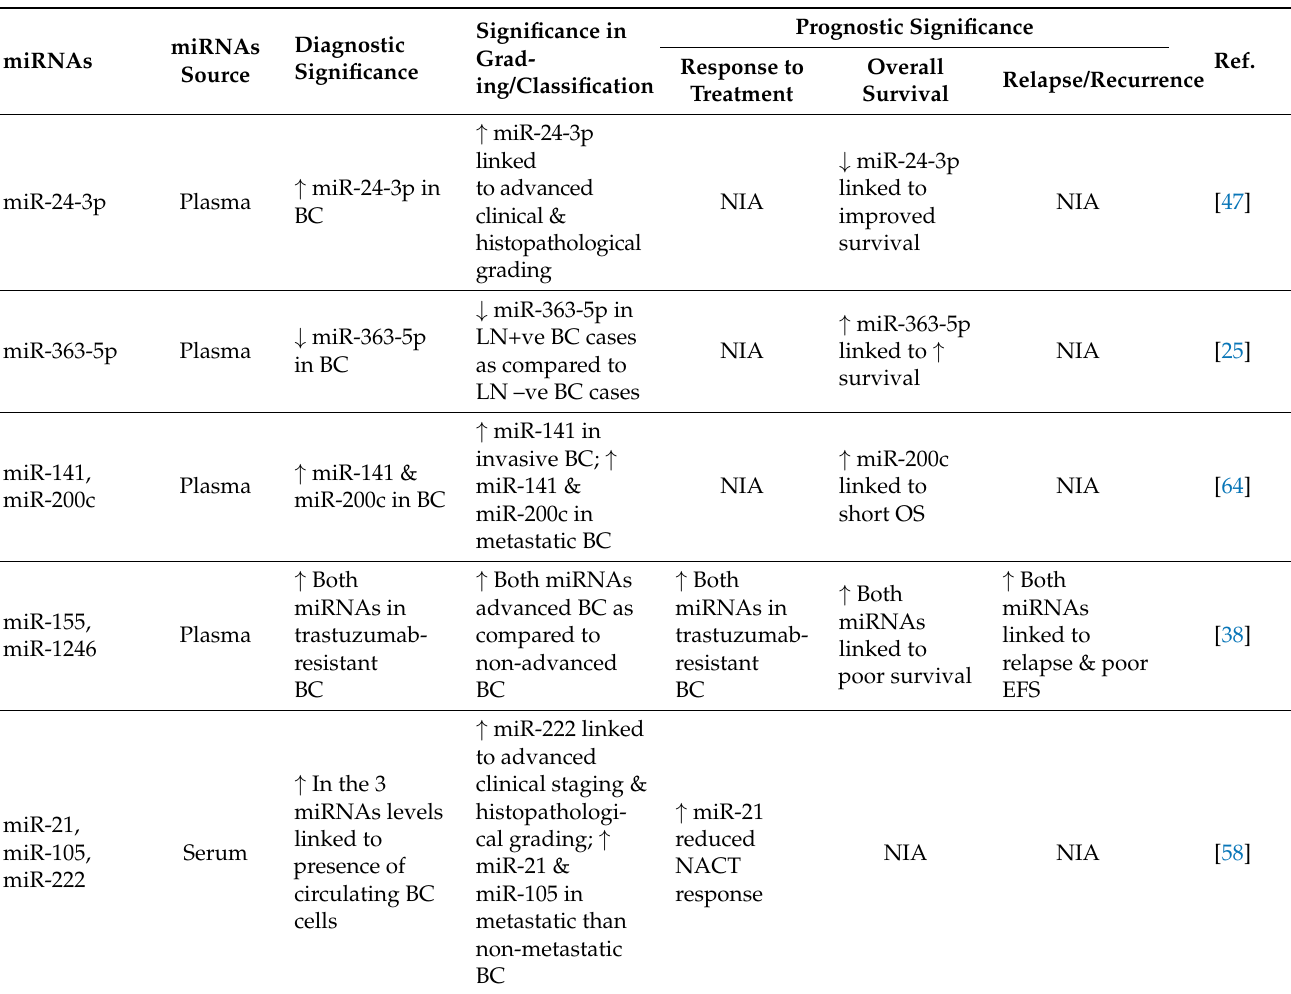
Table 4. Potential exosomal and extracellular-vesicle miRNAs in diagnosing and predicting the prognosis or treatment responses among breast cancer patients. ↑ increase; ↓